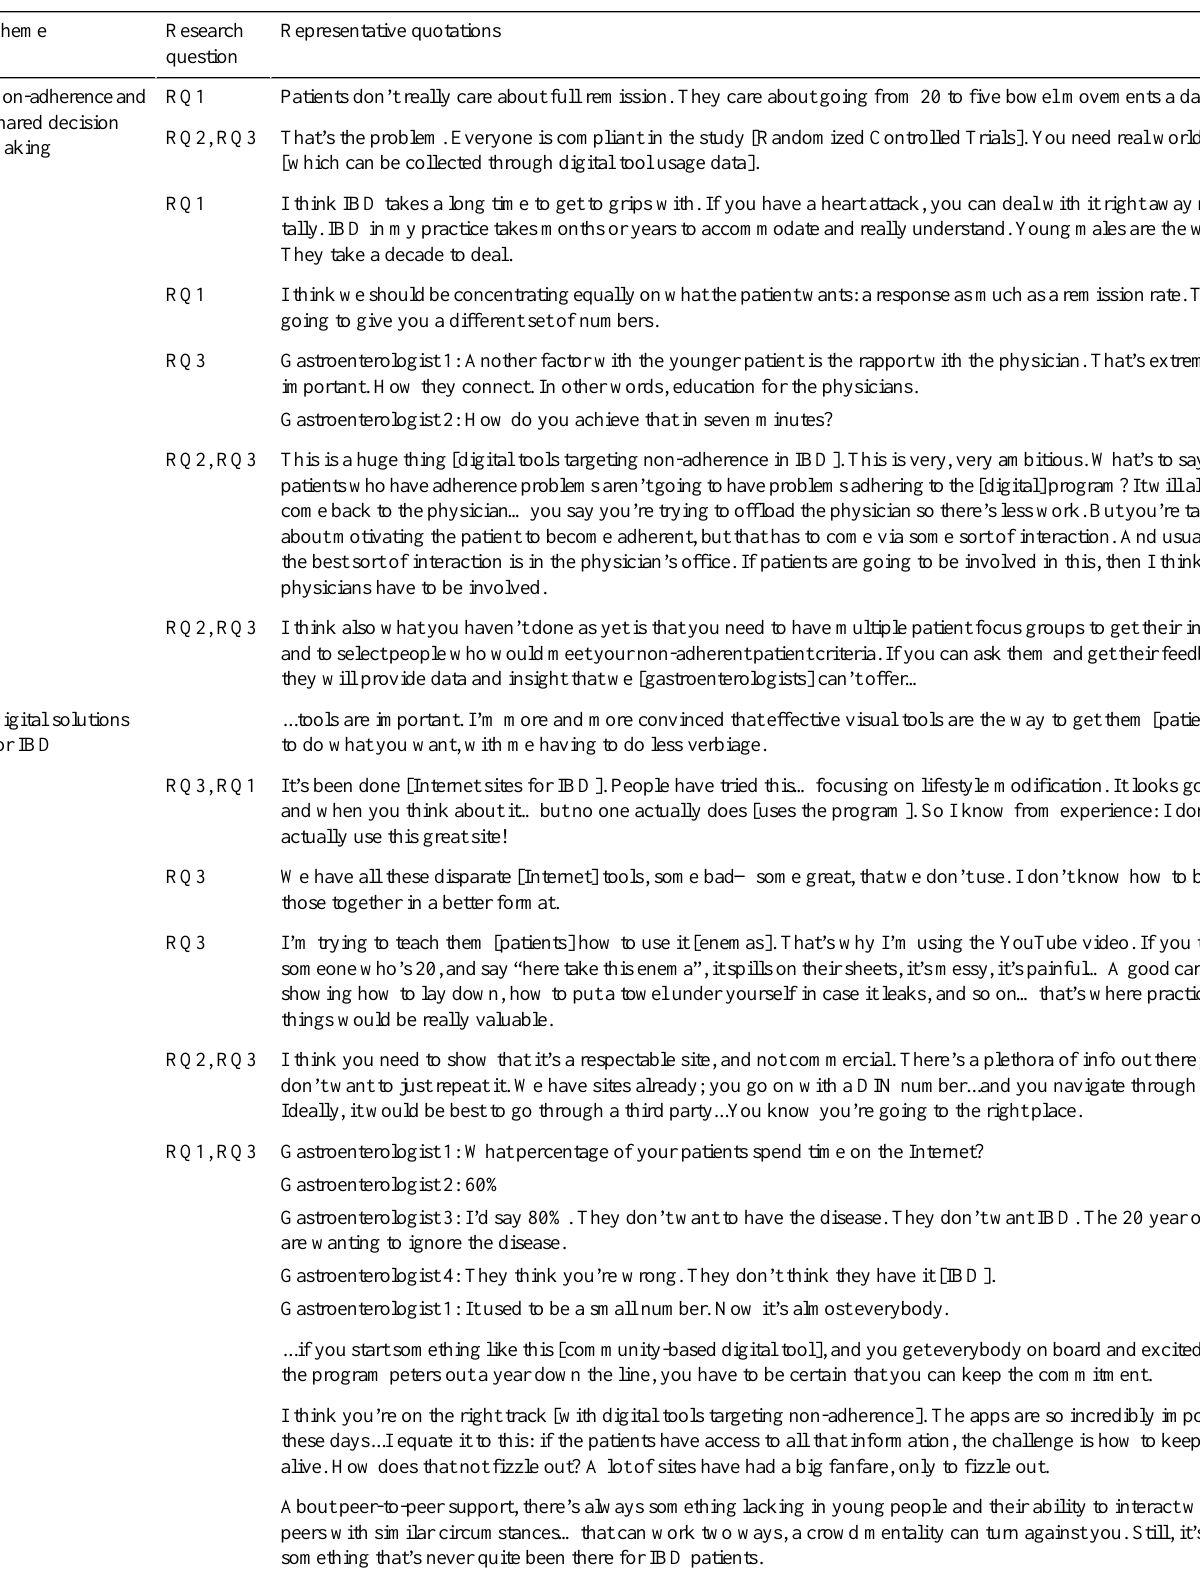
Table 1. Gastroenterologist opinions on non-adherence, shared decision making, and digital assets. Representative quotationsResearch questionTheme shared